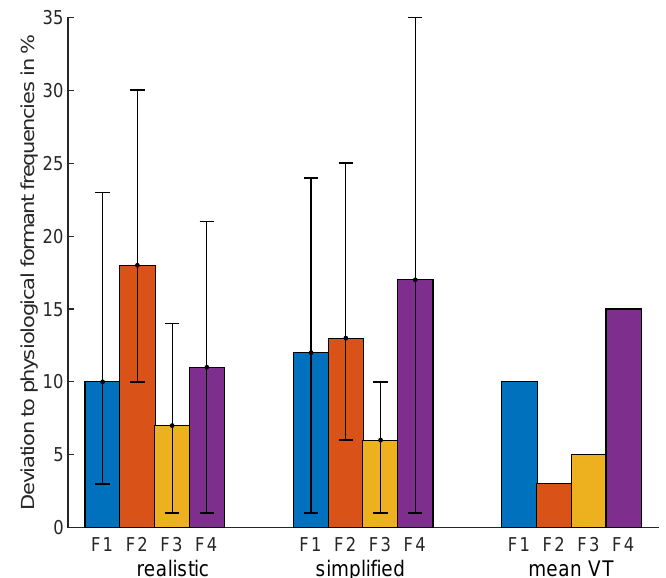
Figure 9. Absolute mean relative deviations of the formant frequencies (F1, F2, F3, F4) of the realistic and simplified VT replicas to the subjects’ formant frequencies [34] based on the MRI-data and audio recordings by Echternach et al. [34] of six tenors singing the vowel /a/. The errorbars mark the minimum and maximum relative deviation appearing among the subjects for the particular formant. The applied detection method for all formants is based on inverse filtering, as described in Section